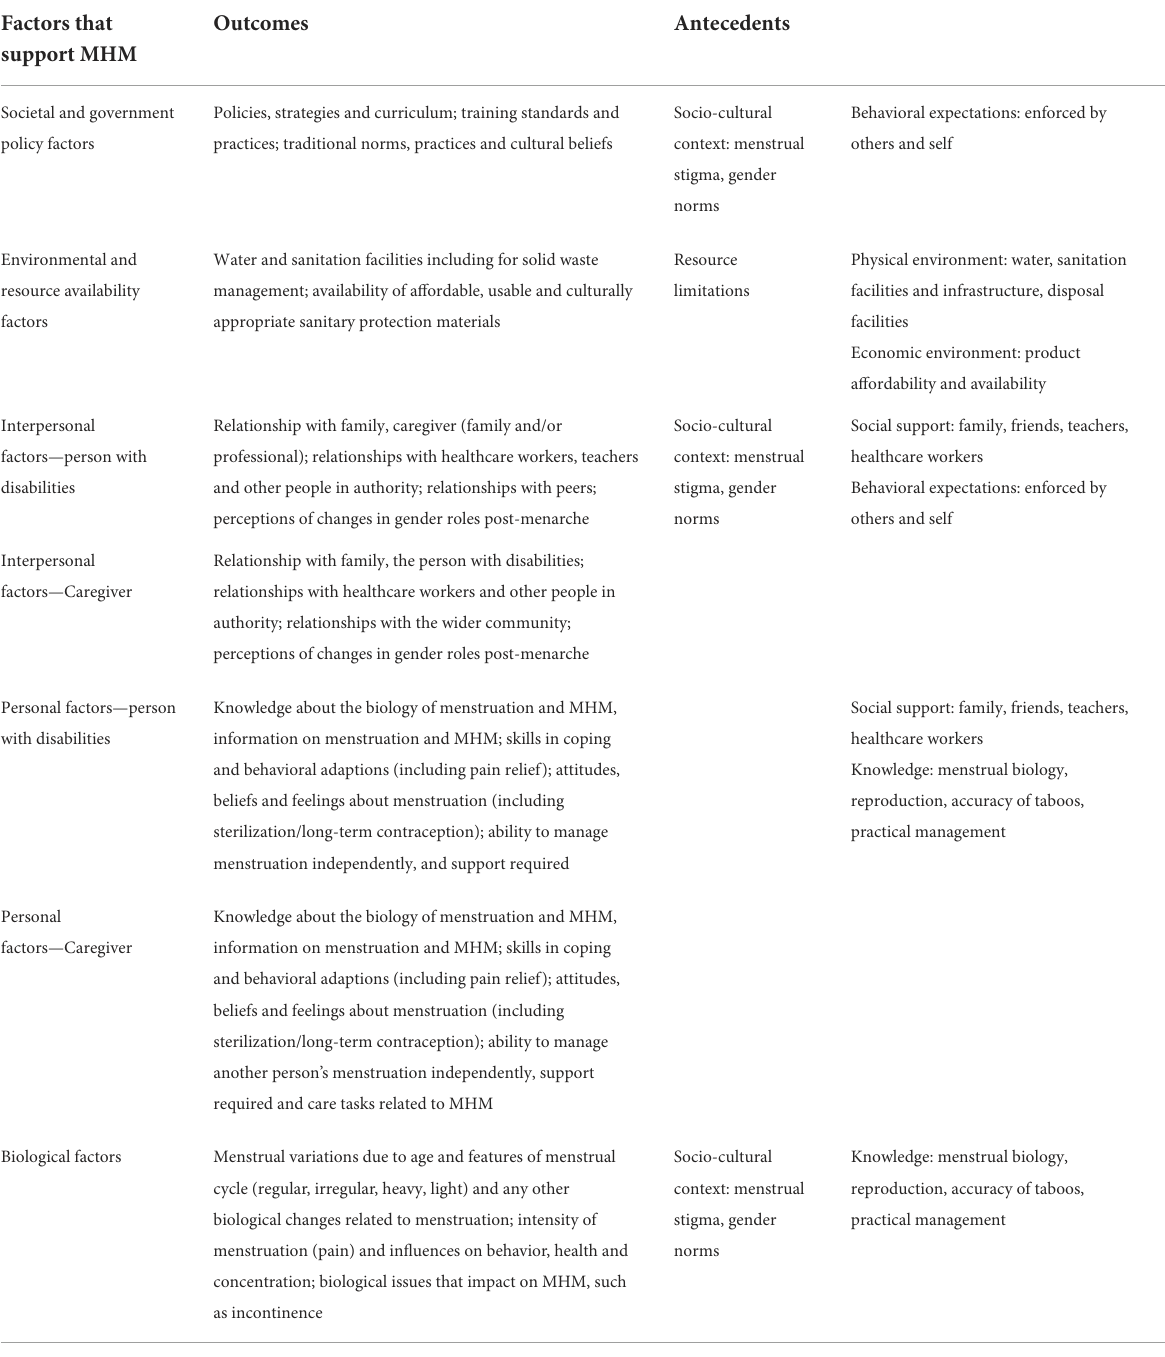
TABLE 1 Socio-ecological framework for menstrual hygiene management, adapted for disability compared to the integrated model of menstrual experience. Socio-ecological framework for MHM, adapted